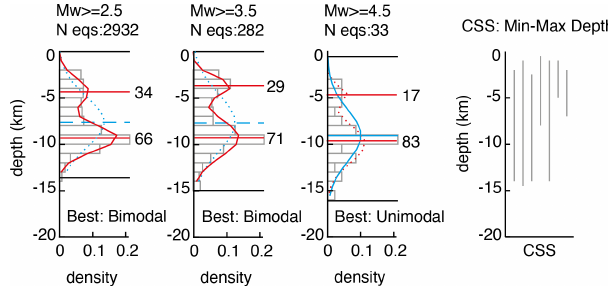
Figure 3. Hypocentral-depth distributions (grey bars) for different threshold magnitudes (reported on top of each panel along with the number of considered earthquakes) for area source no. 24. Black lines correspond to the 5th and 95th percentiles, assumed to be the upper and lower seismogenic depths (round value); blue curve and line represent the unimodal distribution and its modal value; red curves and lines represent the bimodal distribution and its two modal values. Solid lines indicate the best model between uni- and bimodal distributions; dashed lines indicate the other model. The right panel shows the depth ranges of the composite seismo- genic sources (CSSs) of DISS 3.2.1 inside the area. The depth of the Moho, from Solarini and Cassini (2007) and Di Stefano et al. (2011), is approximately 30–35km.